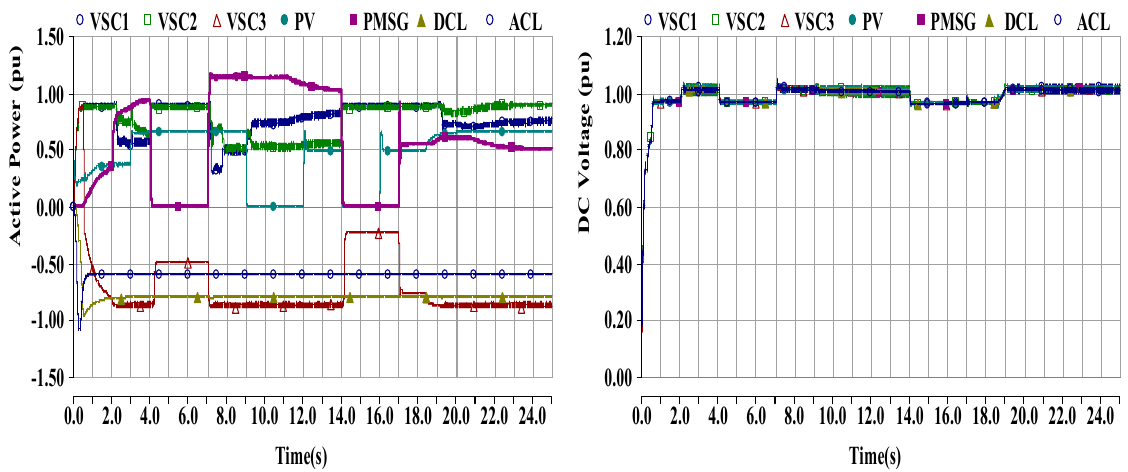
Figure 10. Active power and DC voltage of the MVDC network connected to the IEEE-39 Bus System under the proposed hierarchical control scheme with DC OPF secondary during tripping of REs.